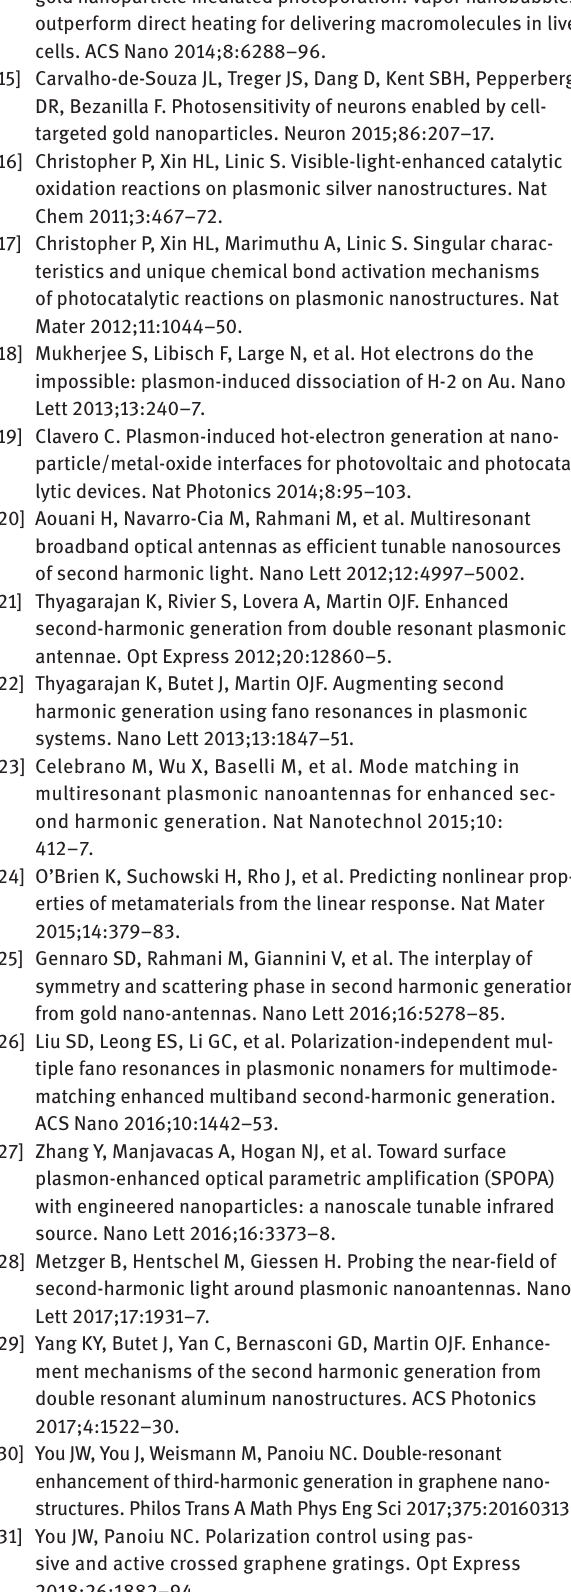
figure out the ways to avoid or decouple the cross-talking of nanoscale plasmonic effects (e.g. enhanced far-field scattering, near-field optical enhancement, nanolocal- ized heating, and nanolocalized hot carrier generations) between different optical modalities at different operation wavelengths. Possible solutions may include applying the cross-correlation time gating and lock-in amplifier detec- tion